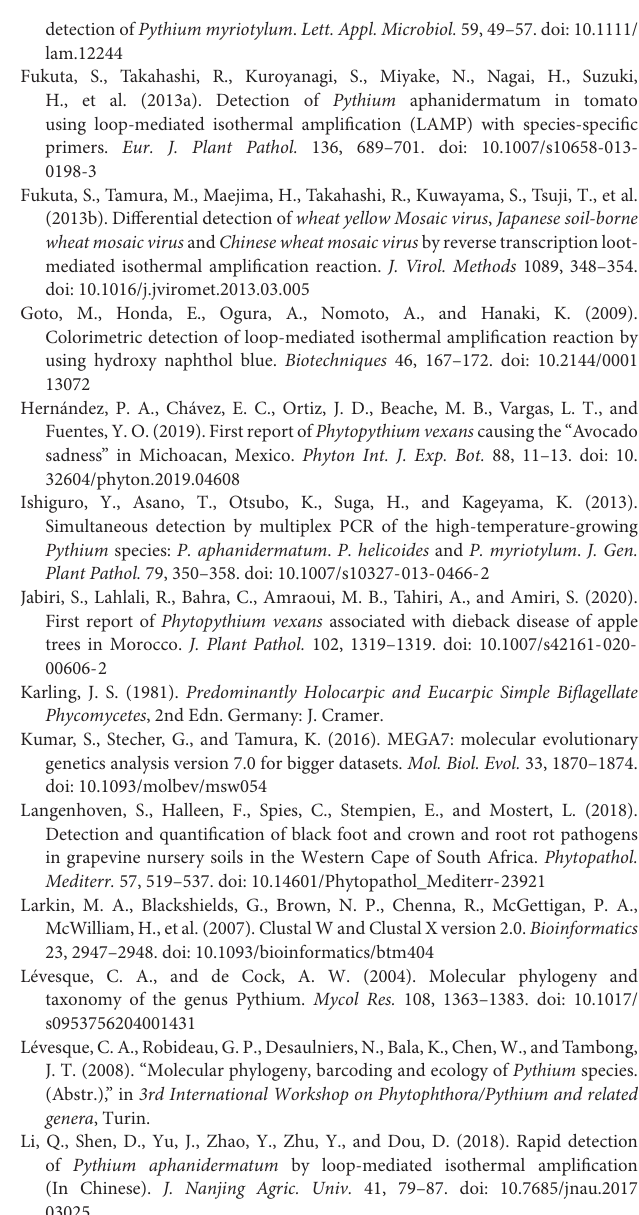
Supplementary Figure 1 | Maximum likelihood tree showing phylogenetic relationships among the 19 tested species. The tree was constructed based on ITS sequence of oomycetes listed in Table 1 . Statistical support for the branches was assessed by bootstrap with 1,000 replicates. Bootstrap values above 50 are shown near the branch